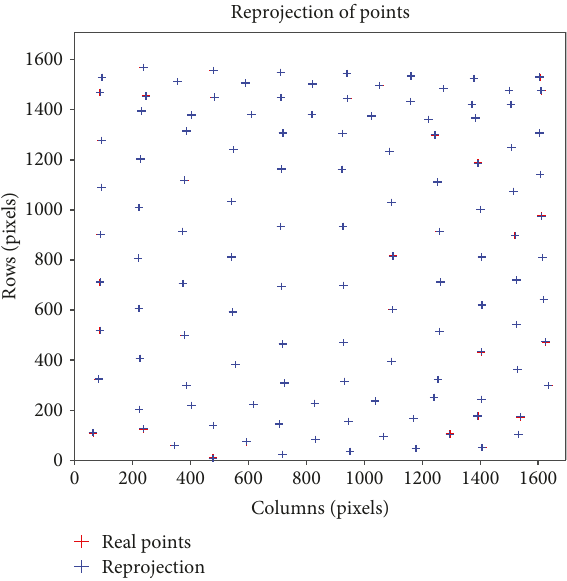
Figure 22: Reprojection of the markers of the calibration fi eld according to the model developed with the parameters identi fi ed for the rear camera.